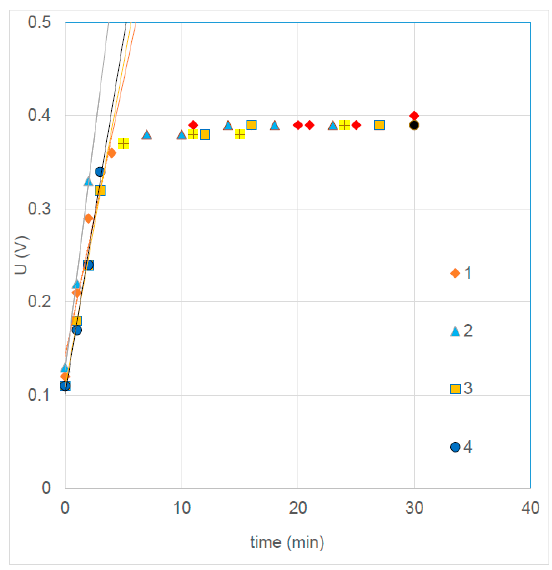
Figure 12. Anodizing potential of four silver plates.